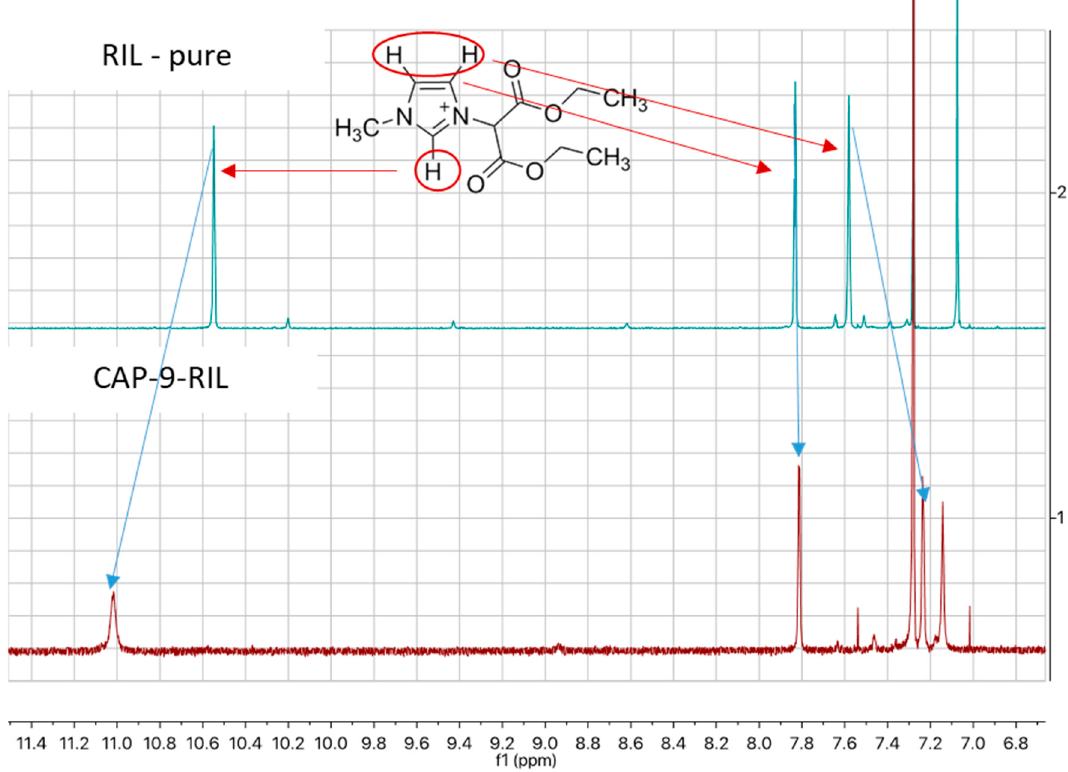
Figure 7. 1H nuclear magnetic resonance (NMR) spectra of pure RIL and CAP-9-RIL membrane.